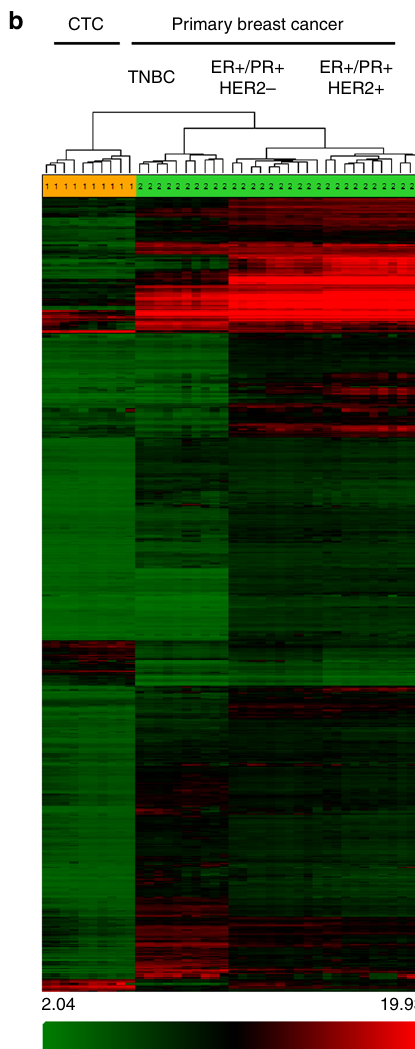
Figure 2 Comparison between CTC and primary breast cancer transcriptomes. a Volcano plot showing global gene expression changes in CTCs vs. primary breast cancer ( pBC ). b Heat map showing differential expression of 4528 genes in patient-derived CTCs vs. pBC (fold-change < − 10 or > 10, ANOVA p -value < 0.05). Note: data from metastatic breast cancer tissue using HTA2.0 array is not publicly available for comparison at present. c Signi fi cantly altered canonical pathways and cellular functions in patient-derived CTCs compared with